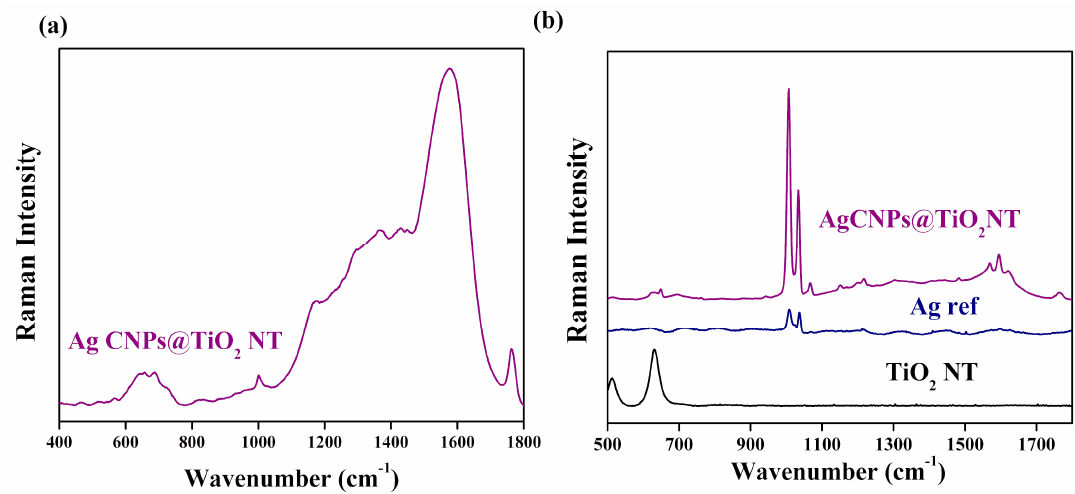
Figure 12. SERS spectra for Ag CNP S deposited on TiO 2 nanotubes (violet) without pyridine ( a ) and with pyridine ( b ); the SERS reference spectrum for electrochemically activated Ag is also given (blue).